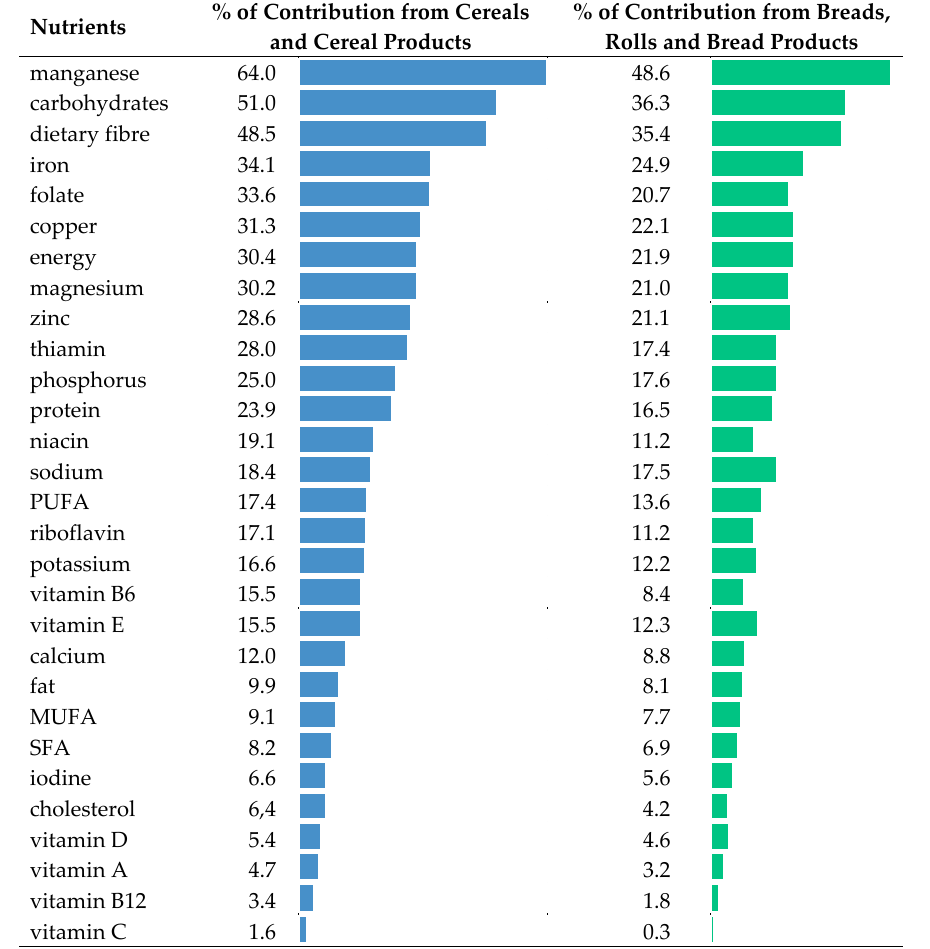
Figure 2. Contribution of energy and nutrients in the average Polish diet from the category of cereals and cereal products and from breads, rolls, and bread